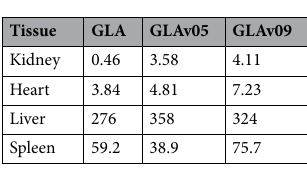
Table 3. Mouse tissue AUC 0-24 (µg·h/g).